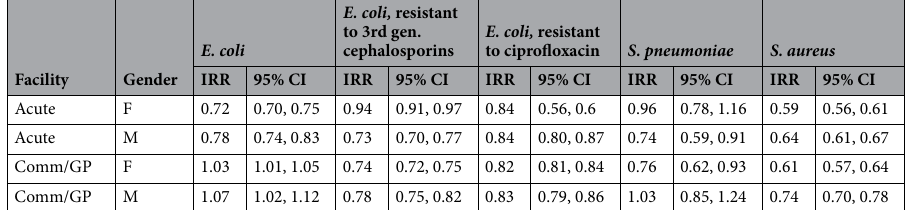
Table 4. Incidence rate ratios (IRR, and 95% confidence intervals) comparing isolation of E. coli (including resistant E. coli populations), S. pneumoniae and S. aureus from microorganisms recorded in SGSS April 2015 to August 2016, stratified by UK Biobank status. Microbiological isolations occur both in hospital samples (Facility = ‘Acute’) and out of hospital community settings/general practice (Facility = ‘Comm/ GP’). Populations at risk of isolation differ between these populations: we used UK Biobank subjects as the denominator for the UK Biobank subjects, and the number of individuals 45–69 in mid 2015 as a denominator for non-UK Biobank